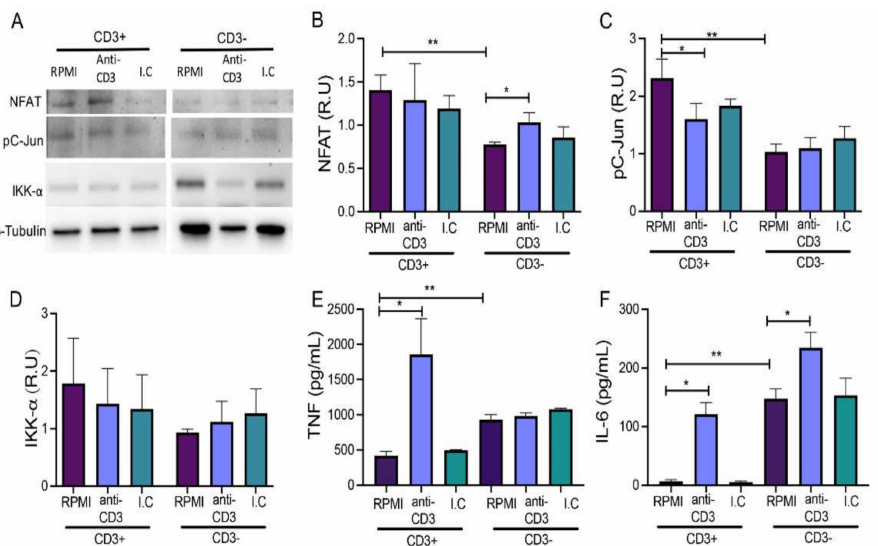
Figure 3. Anti-CD3 stimulation induces the production of TNF and IL-6 in CD3+ RAW cells. ( A ) Sorted RAW cells were used to evaluate NFAT, phosphorylated C-Jun (pC-Jun), and IKK- α by immunoblot. β -Tubulin was used as a loading control. CD3+ and CD3- RAW cells were cultured for 24 h under the following conditions: RPMI, anti-CD3, and isotype control (I.C). ( B ) Relative units (R.U) of NFAT-1, ( C ) pC-Jun, and ( D ) IKK- α in RAW CD3+ and CD3- cell lysates. TNF and IL-6 levels (( E , F ), respectively) were measured in supernatants collected from CD3+ and CD3- RAW cells by ELISA. n = 3 independent experiments (for immunoblot) and n = 3 independent experiments performed in triplicate (for ELISA). Bars represent the mean value ± SD ( B – D ) or the mean of means ± SEM ( E , F ). Kruskal–Wallis and corrected for the Dunn test were used for immunoblot data and one-way ANOVA followed by Bonferroni test for ELISA. * p < 0.05, ** p <